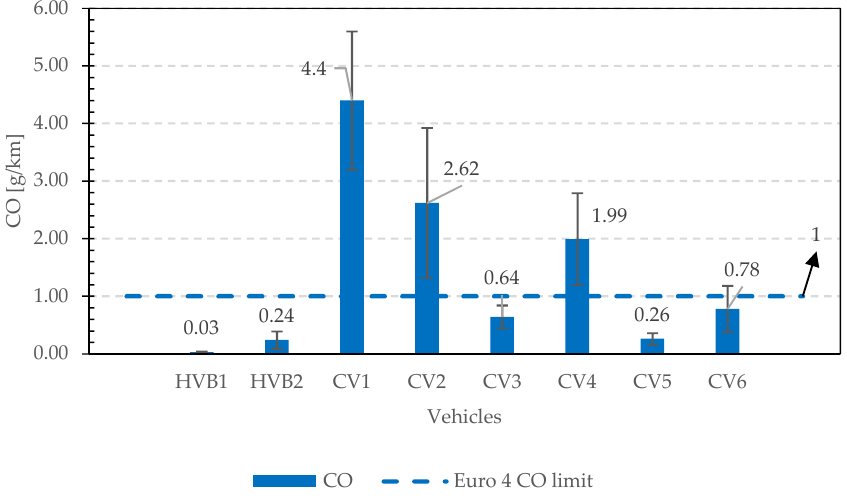
Figure 9. THC and NO x emissions of the examined vehicles.